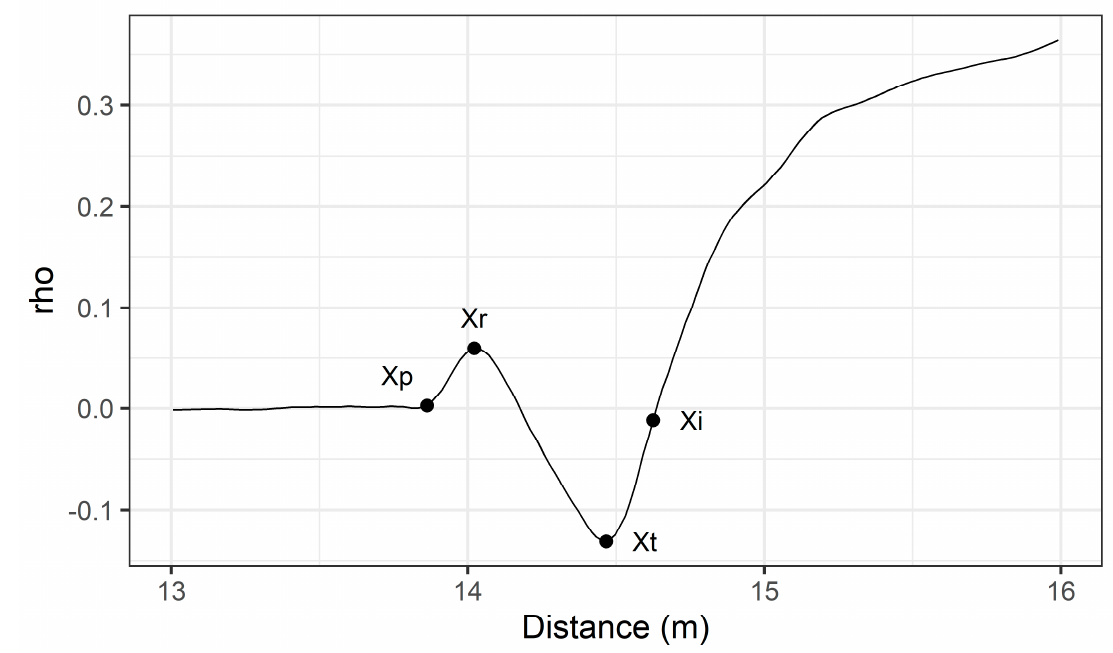
Figure 1. Typical time-domain reflectometry waveform in wet wood ( > 75% moisture content), showing the two main methods for determining apparent length. Xp is the signal entering the probe head from the coaxial cable, X r is the signal leaving the probe head and the starting point for measurement of the waveform, Xt is the signal at the end of the rods using the tangent line approach, and Xi is the inflection point of the rising curve method.